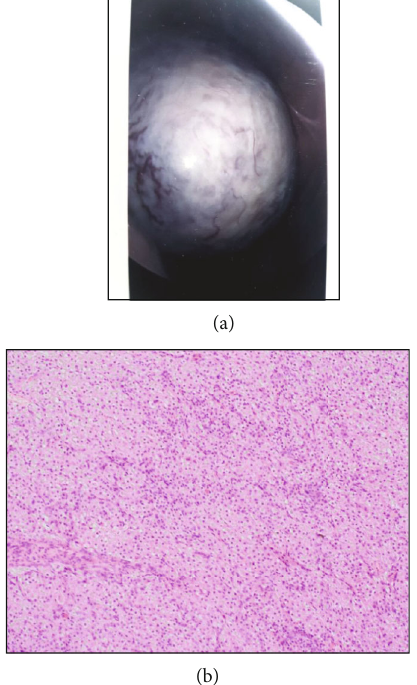
Figure 2: (a) Diagnostic laparoscopy: left adnexa consisted of a fallopian tube attached to a 120 × 120 × 100 mm grey, solid ovarian mass with a smooth surface and dilated vessels. (b) Microscopic appearance of a steroid cell tumour showing large arrogates of typical polygonal-to-round tumour cells having distinct cell borders, central nuclei, prominent nucleoli, and moderate-to-abundant spongy or eosinophilic granular cytoplasm, intersected by delicate fi brous bands (courtesy of Dr. Kasim Ismail, reporting pathologist, and Dr. Julia Low, Liverpool Hospital, NSW,